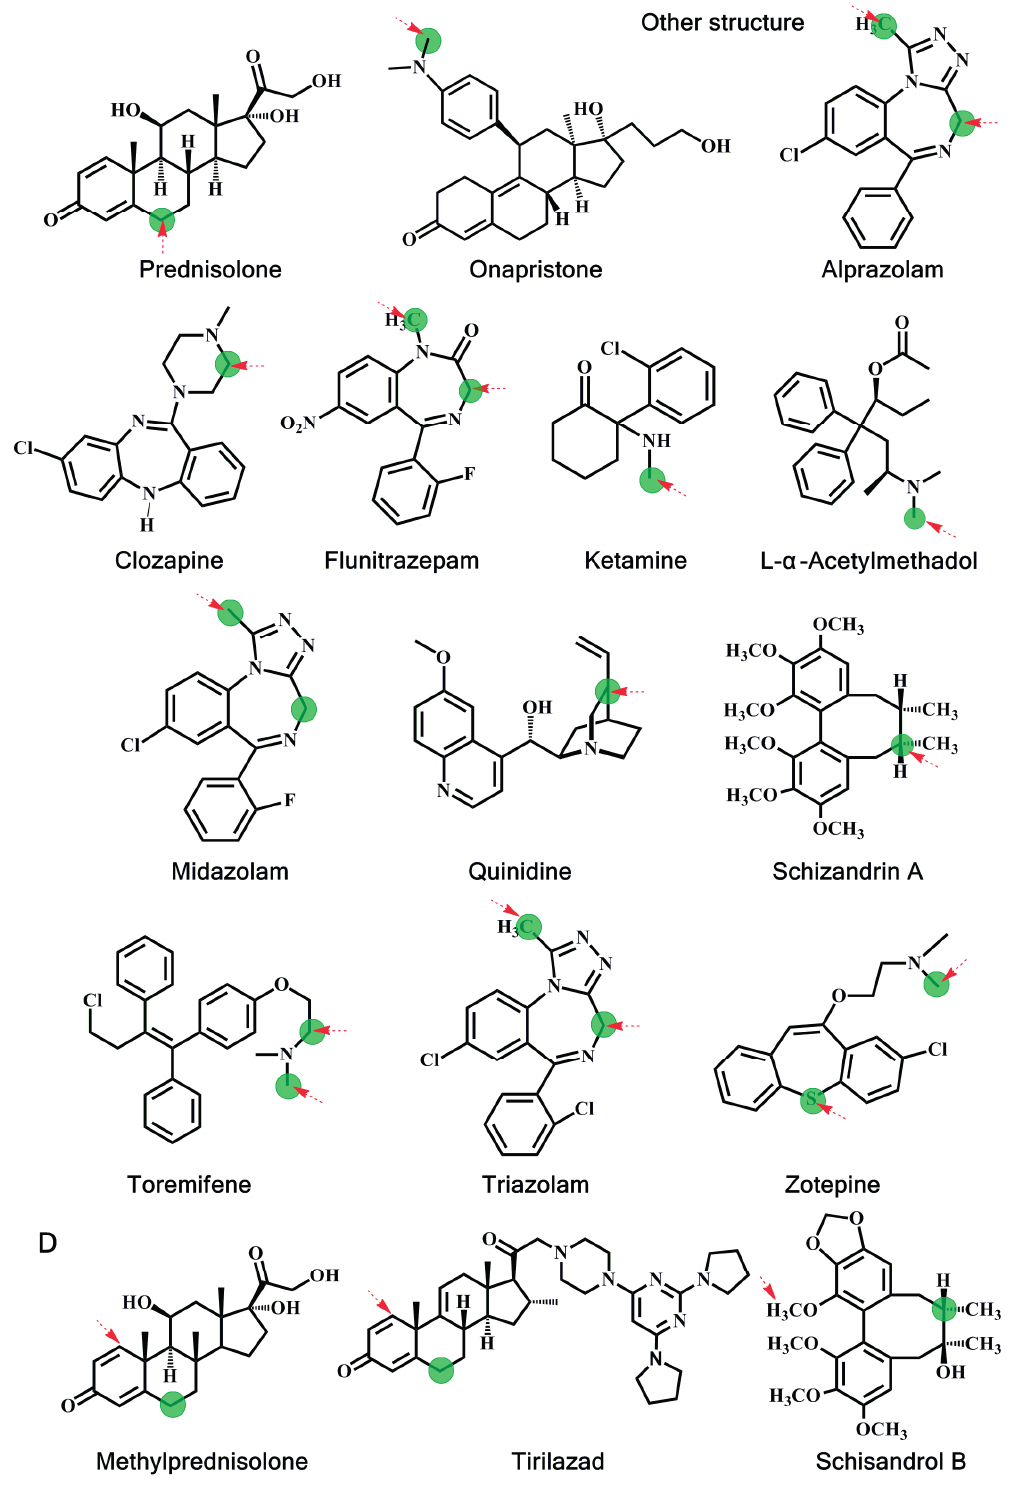
Figure 3. Chemical structures of: ( A ) Successful cases in the training set; ( B ) Failed cases in the training set; ( C ) Successful cases in the test set; and ( D ) Failed cases in the test set. Experimentally known major sites of metabolism are indicated with a green circle. Predicted sites with the mechanism-based prediction model are indicated with an arrow. DHEA,